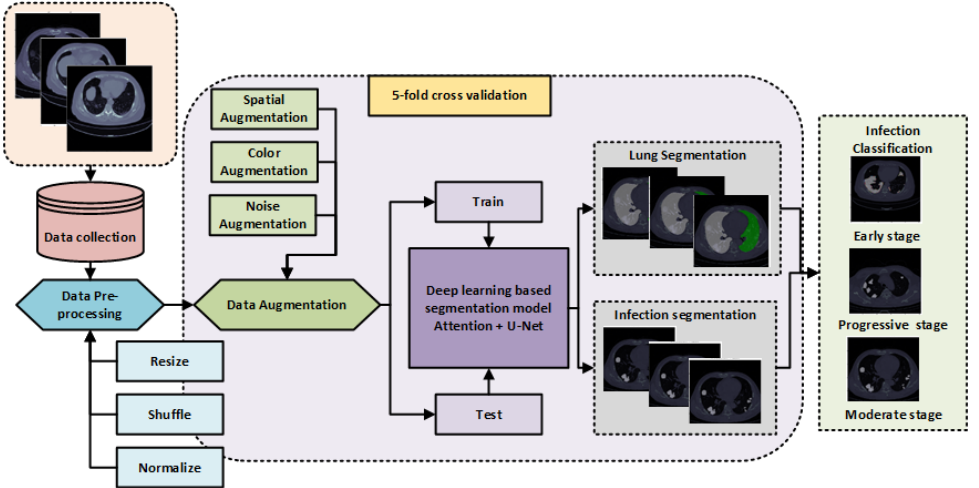
Figure 2. General flowchart of the framework developed for biomedical image examination of COVID-19 infection found in CT scans of chest/lungs. The workflow starts with the collection of the data set, the pre-processing step, data augmentation, and train/test splitting. In addition, the U-Net model is utilized for lung segmentation and infection in CT images. Finally, the detected infection mask is classified into three stages, i.e., early, progressive, and severe. The flowchart concludes with the estimated results of the assessment for a five-fold